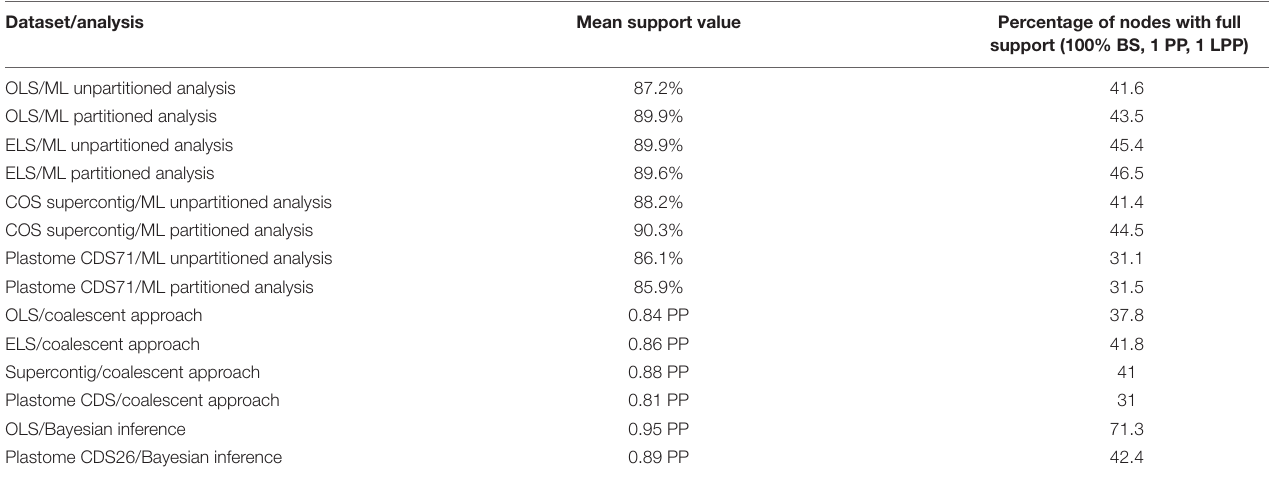
TABLE 2 | A summary of “Mean of support values” and “Percentage of nodes with full support (100% BS, 1 PP, and 1 LPP)” across all analyses.